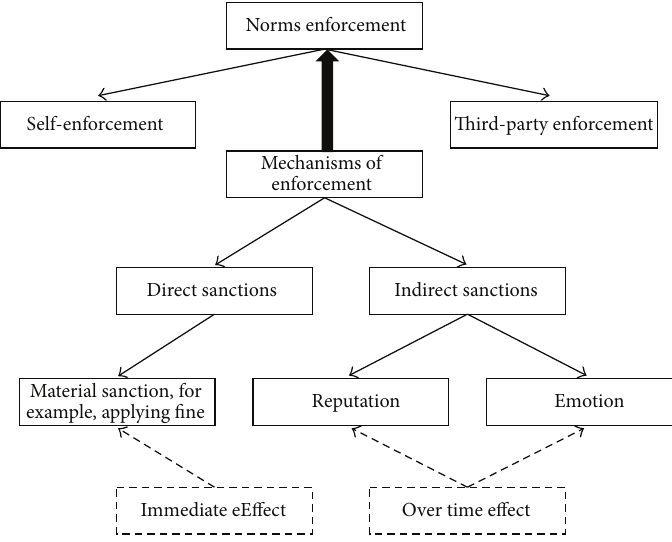
Figure 5: Types and mechanisms of norms